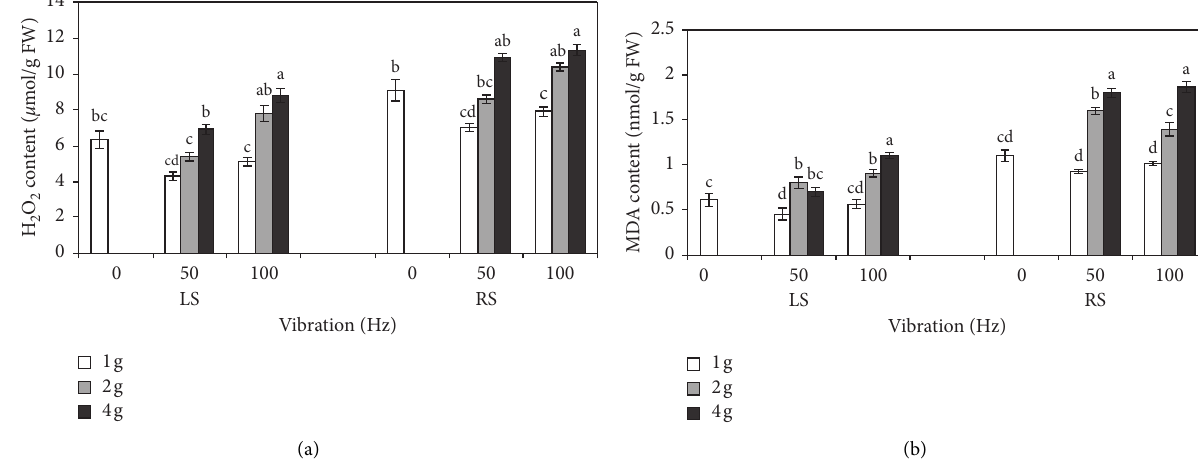
2 O 2 (a) and MDA contents